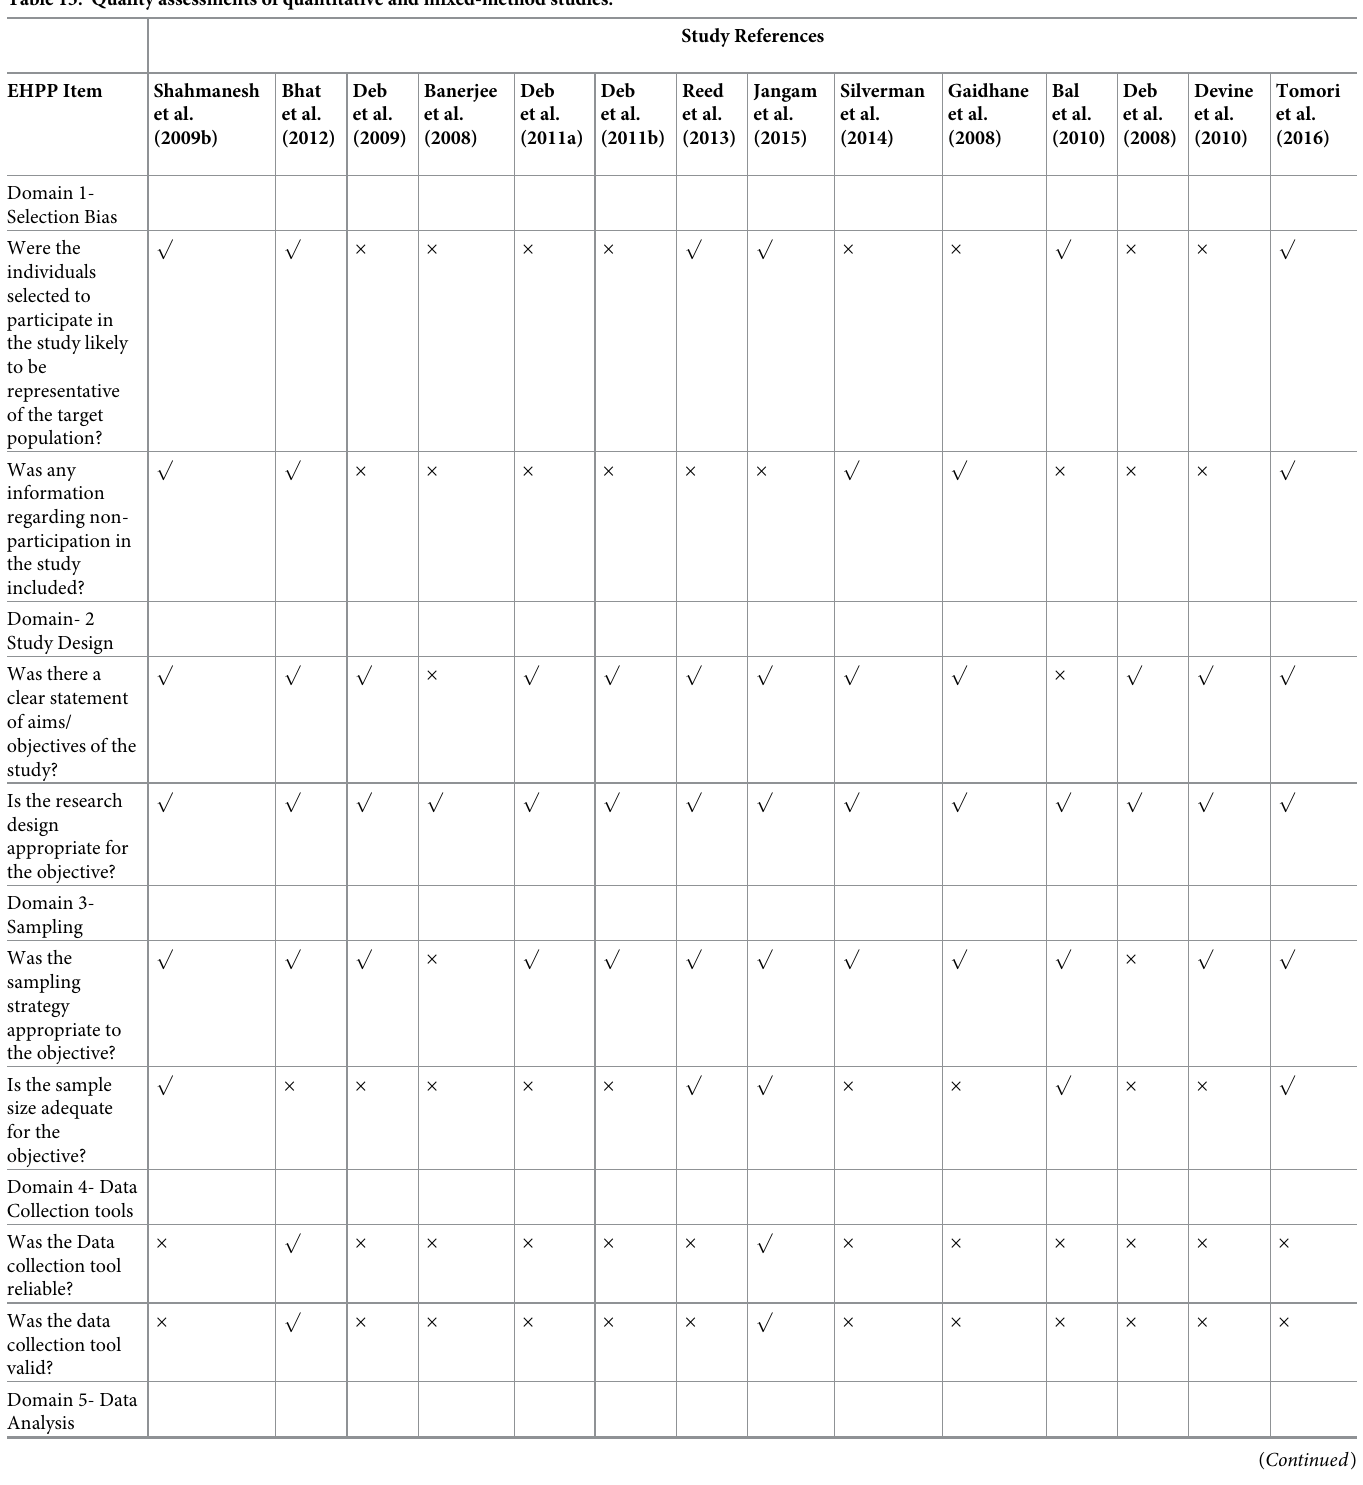
Table 13. Quality assessments of quantitative and mixed-method